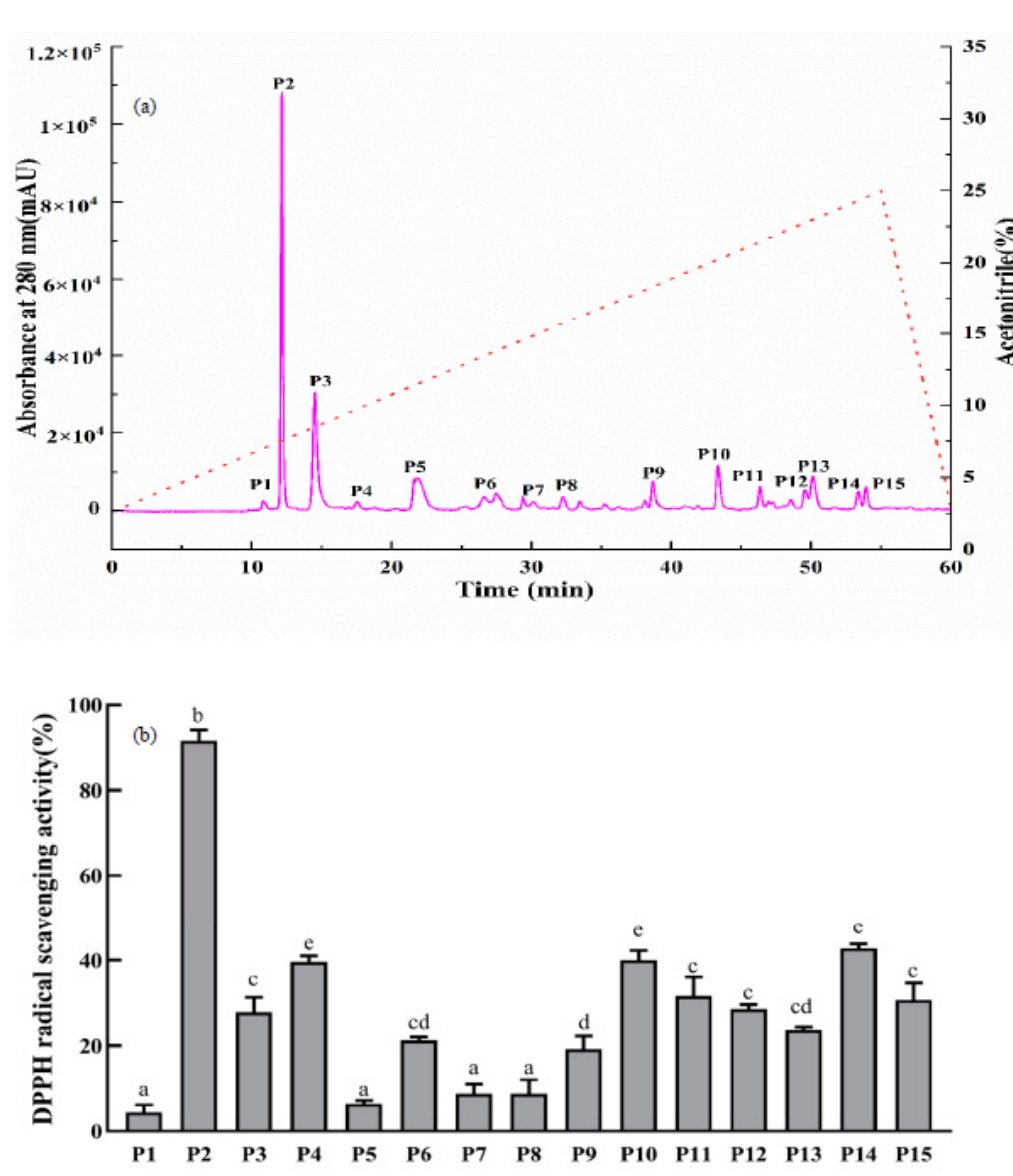
Figure 6. Elution profile of the F3 fraction separated by RP-HPLC ( a ); DPPH radical scavenging activities of the F3 subfractions (P1–P15) at a concentration of 1 mg /mL ( b ). The data indicated as means ± SD (n = 3). The column values of a–d with the same superscript indicated an insignificant difference ( p > 0.05).